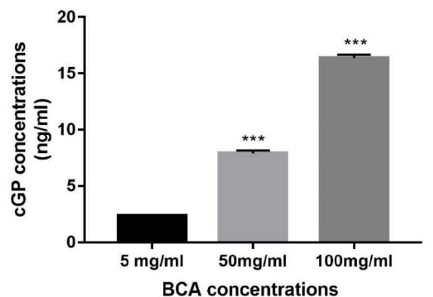
Figure 2. A dose-dependent increase of cGP concentration in the BCA. Data presented as mean ± SEM, *** p < 0.0001.